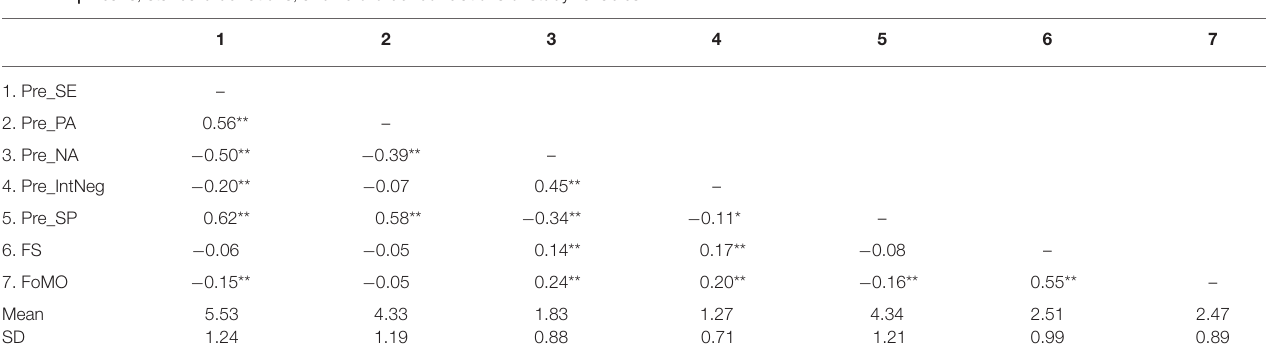
TABLE 1 | Means, standard deviations, and zero-order correlations of study